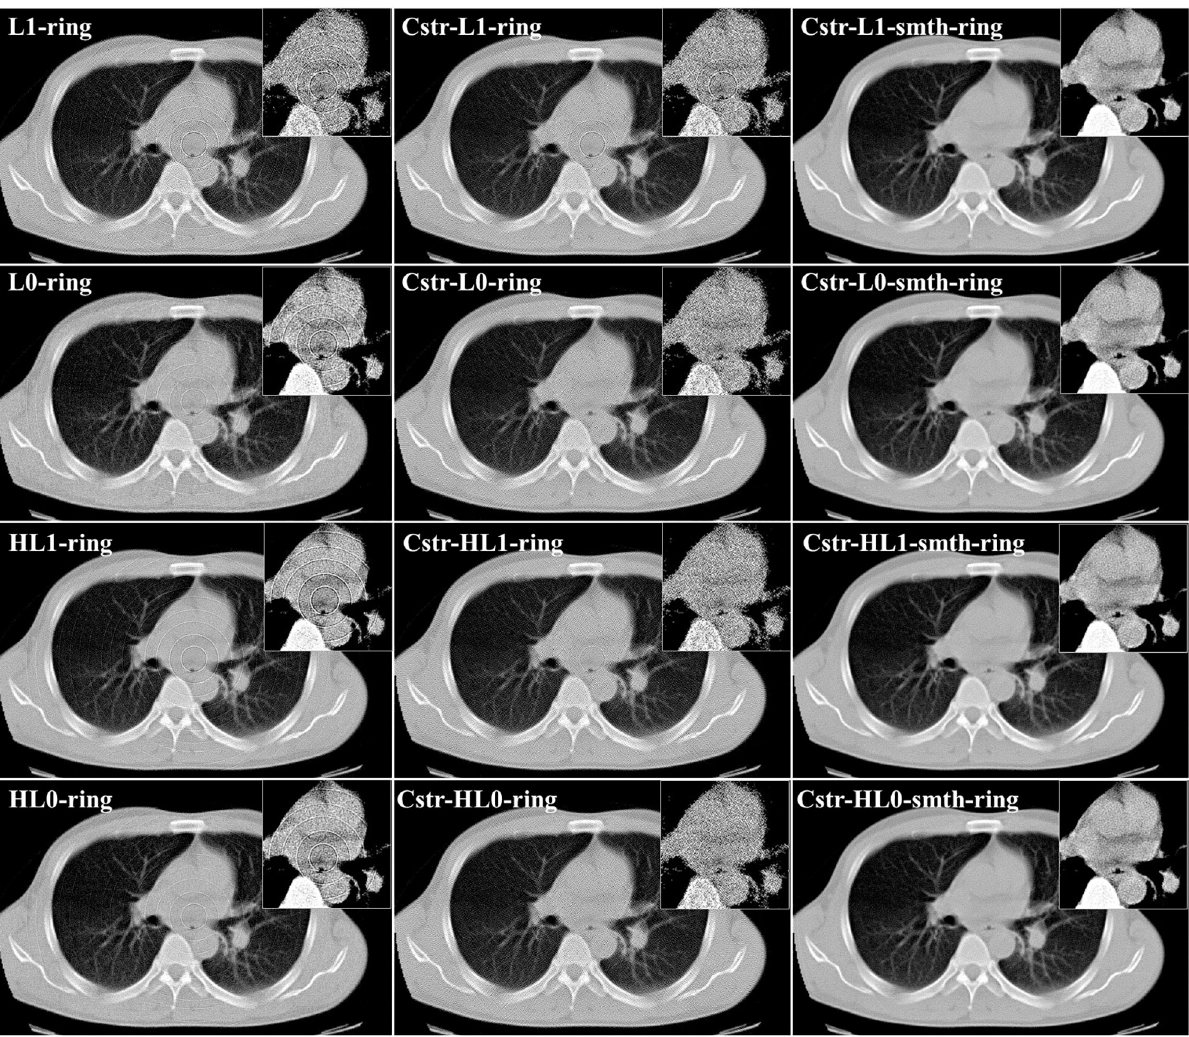
Fig 10. Comparison of reconstructed images between the proposed algorithms and their angular constrained forms in the case of noisy projection data (noisy projection data, non-adjacent error detector bins, and angular-independent error case).